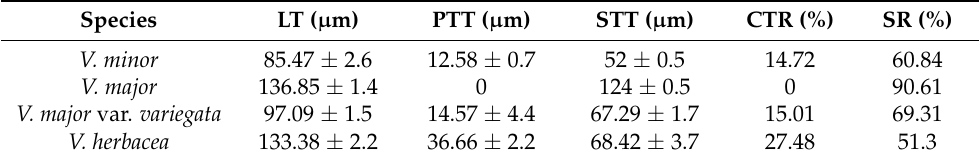
Table 2. The anatomical features measured on the Vinca leaves.